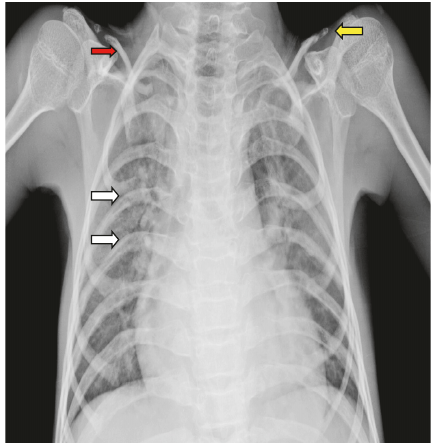
Figure 1: Frontal chest radiograph showing cardiomegaly, sloping slender fifth and sixth posterior ribs (white arrows). The absence of lateral and medial end of both clavicles (red arrow) with a tiny bone fragment was seen in the acromial end of both clavicles (yellow arrow).